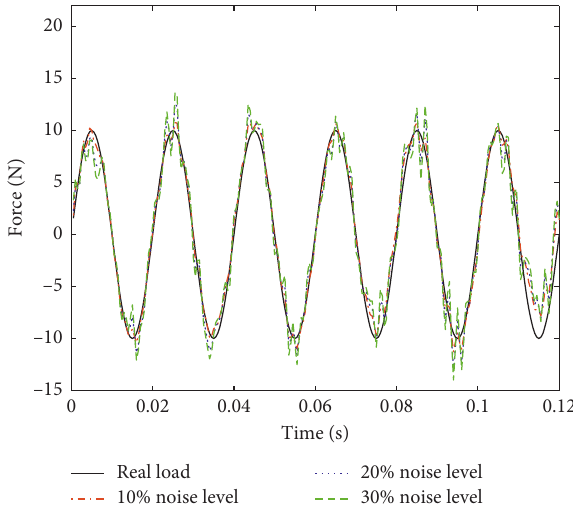
Figure 5: Identification results of TSVD under 10%, 20%, and 30% noise